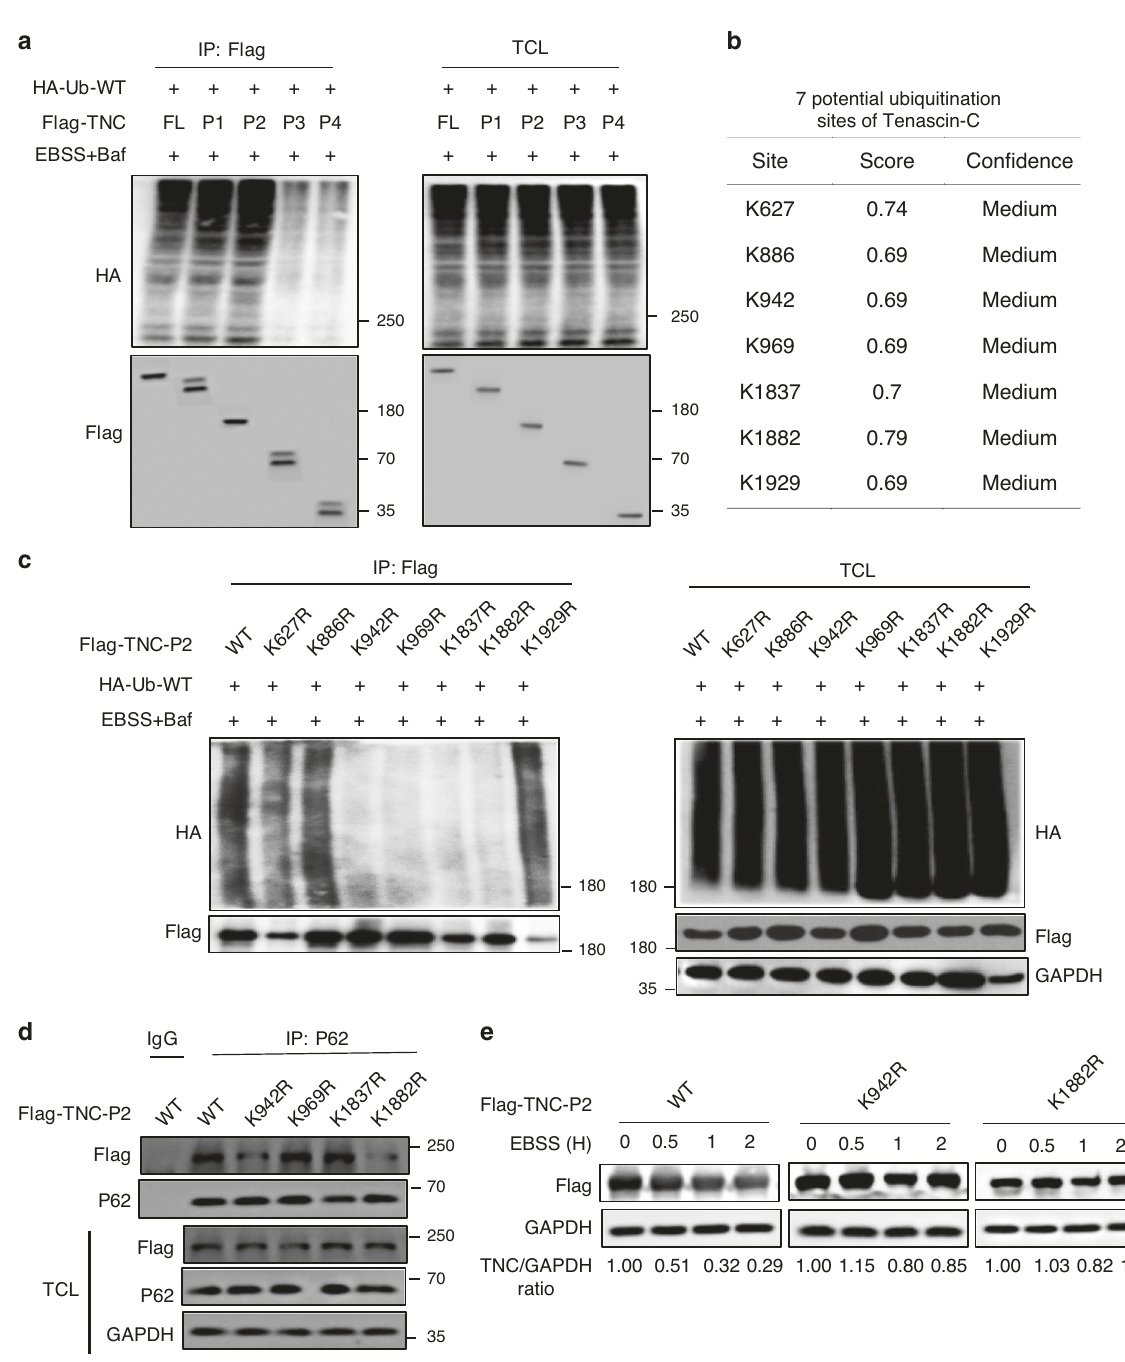
Fig. 6 Identi fi cation of the ubiquitination site of TNC. a Full-length Flag-TNC and TNC truncation mutants were co-transfected with HA-Ub-WT into HEK293T cells, then followed by EBSS treatment in the presence of BafA1 for 2 h. Immunoprecipitation analysis of exogenous TNC ubiquitination with the indicated antibodies. b Predict the ubiquitination lysine sites of TNC using Ubpred website (www.ubpred.org). c HEK293T cells transfected with Flag-TNC- P2 and indicated TNC mutants along with HA-Ub, then followed by EBSS treatment in the presence of BafA1 for 2 h. Immunoprecipitation analysis of exogenous TNC ubiquitination. d Coimmunoprecipitation and immunoassay of extracts of HEK293T cells transfected with the indicated plasmids. P62 proteins were immunoprecipitated and the bound exogenous TNC proteins examined by immunoblot. e HEK293T cells were transfected with the indicated plasmids, then treated with EBSS at indicated intervals and analyzed by immunoblot. All data are representative of three independent